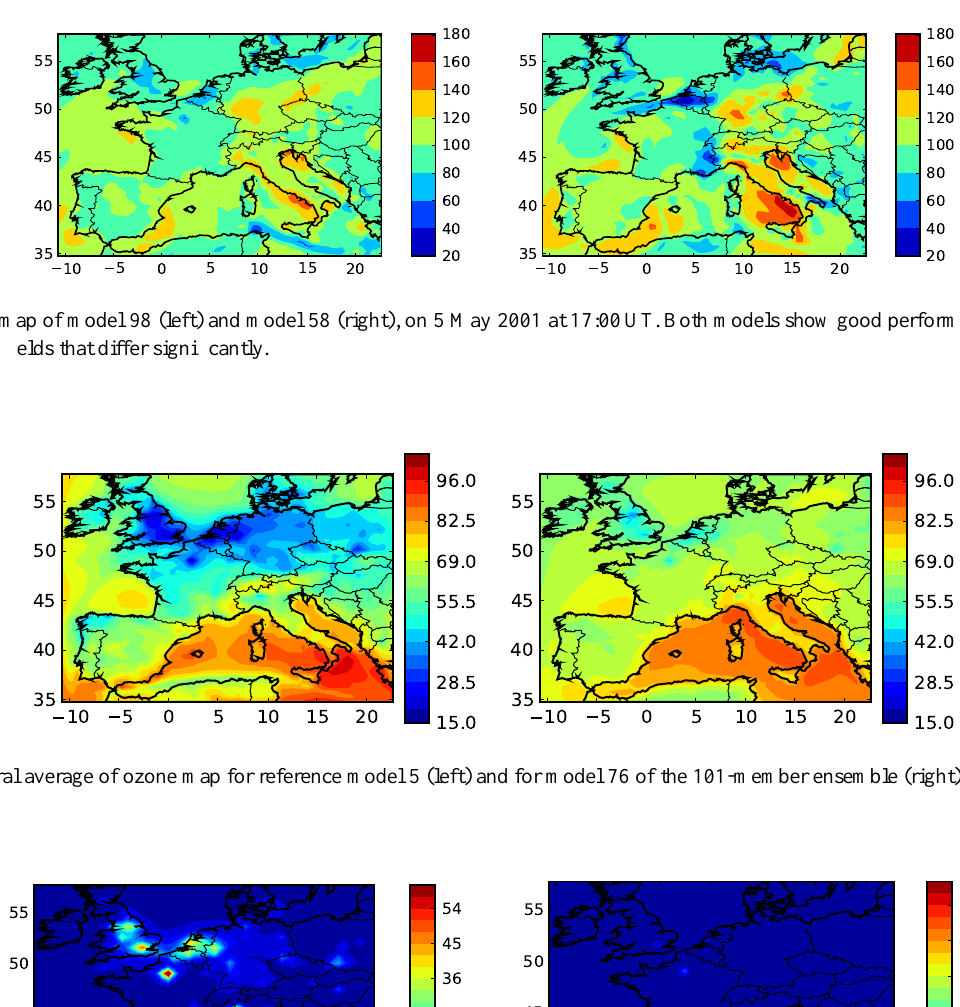
Fig. 10. Temporal average of SO 2 map for reference model 5 (left) and for model 88 of the 101-member ensemble (right). Appendix A 700 Emissions from EMEP As described in section 2, anthropogenic emissions are pro- vided by EMEP. The vertical distribution of the pollutants depends on SNAP category. Two vertical distributions are 705 used in this paper: a “ low distribution” and a “ medium distribution”—see table A1. Acknowledgements. We thank Richard James for proofreading the paper.